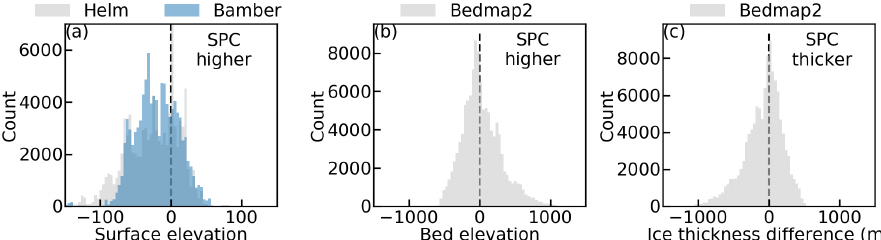
Figure 4. Difference between aerial observations and community DEMs. (a) Laser surface elevation difference for both Bamber et al. (2009) and Helm et al. (2014), (b) radar bed elevation observation difference from Fretwell et al. (2013), and (c) radar ice thickness observation from Fretwell et al.